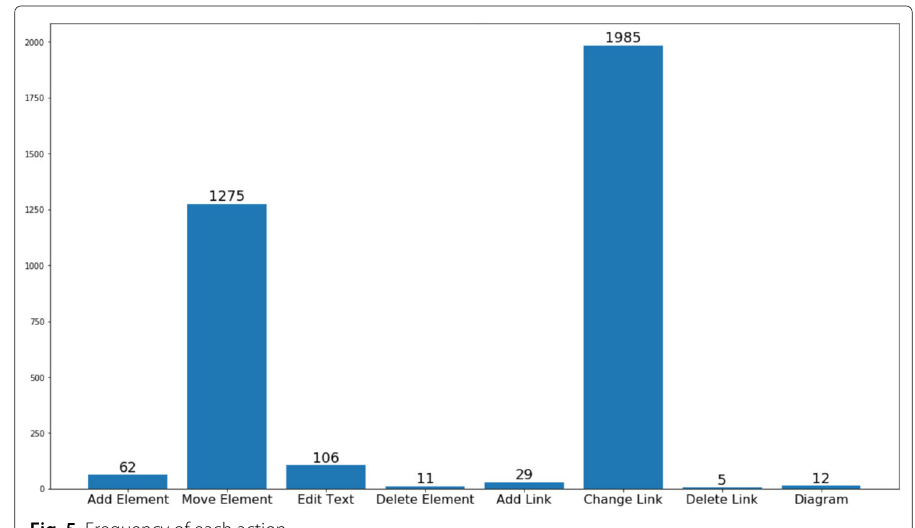
Fig. 5 Frequency of each